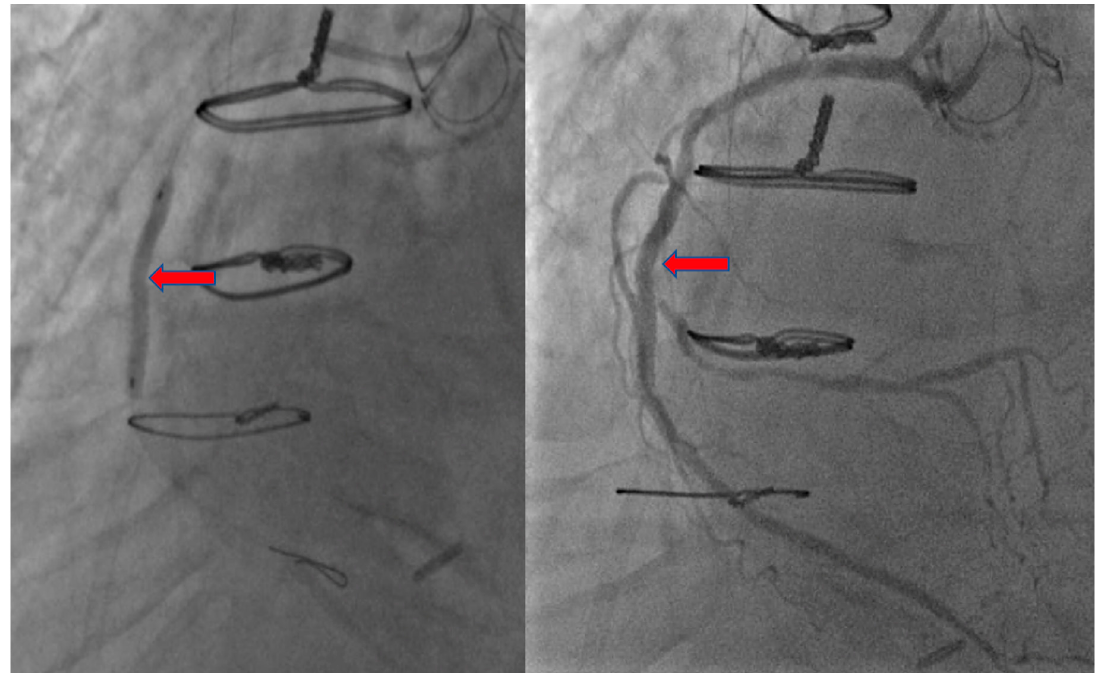
Figure 2. Coronary Angiography of right coronary artery with stent.